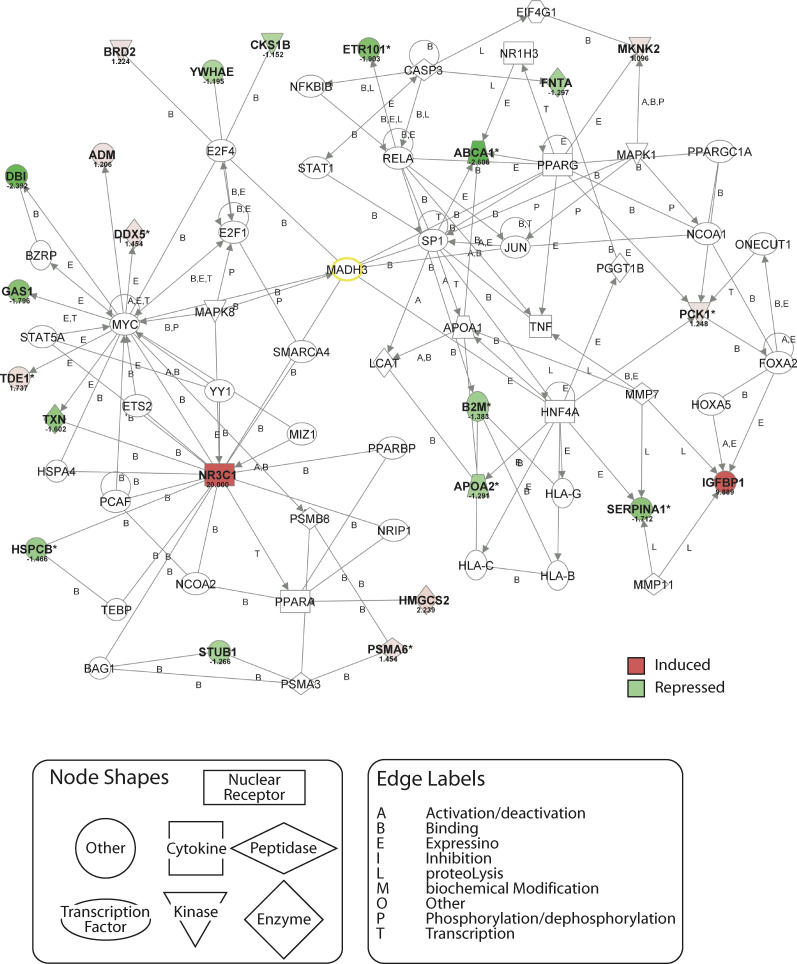
A Regulatory Network for the GRPathway analysis was seeded with the 53 differentially expressed and GR-bound genes, plus the GR itself, as described in Materials and Methods. Genes in colored, bold text were in the seed set, while all others were brought into the network by the pathway analysis program based on their known relationships to the genes in the seed set. Color indicates induction (red) or repression (green) of expression.